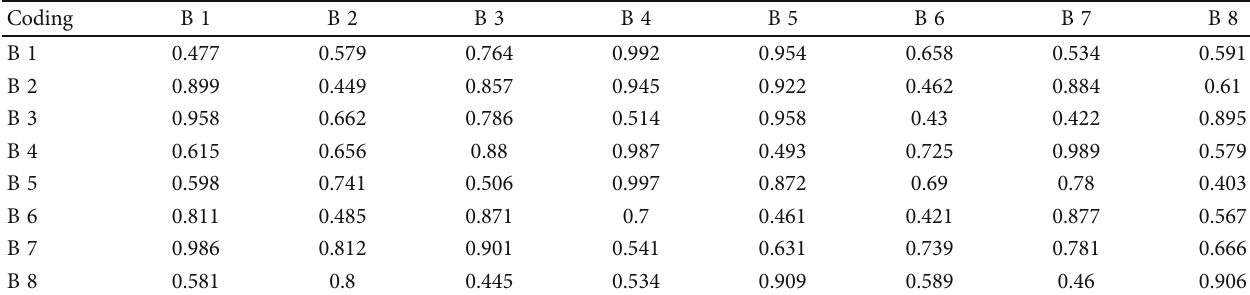
Table 3: Adjusted